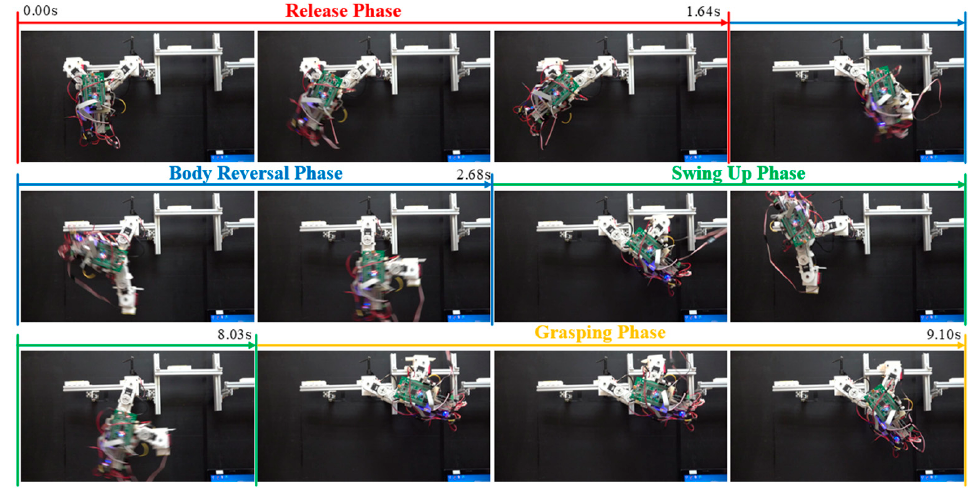
Figure 25. Experimental results (Exp. (h): distance: 192 mm, elevation: 56 mm): ( a ) joint motion; ( b ) predicted wrist joint motion and gripper command timing.